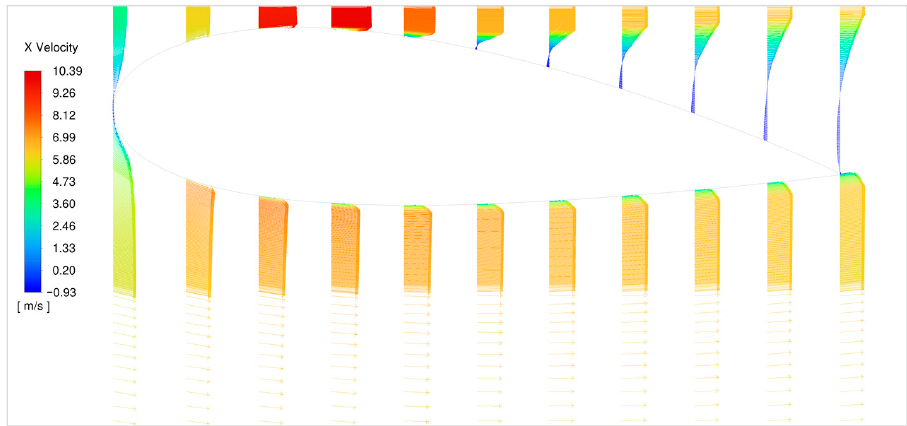
Figure 8. Velocity vectors around the lower airfoil (+5° pitch angle, U ∞ = 5 m/s, 30 cm gap).